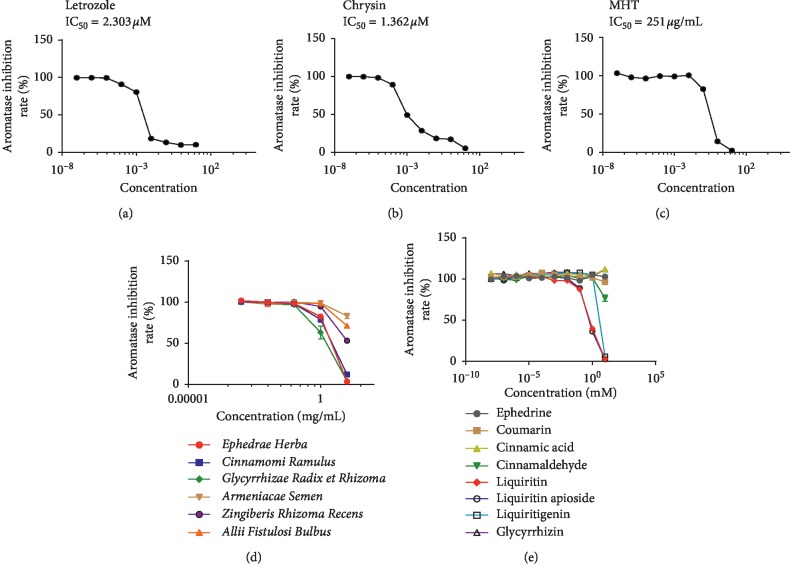
Inhibitory effects of letrozole (a), chrysin (b), MHT hydrothermal extract (c), the compositional herbs of MHT hydrothermal extract (d), and the major compounds of MHT hydrothermal extract (e) on aromatase activity as determined in a cell-free system.